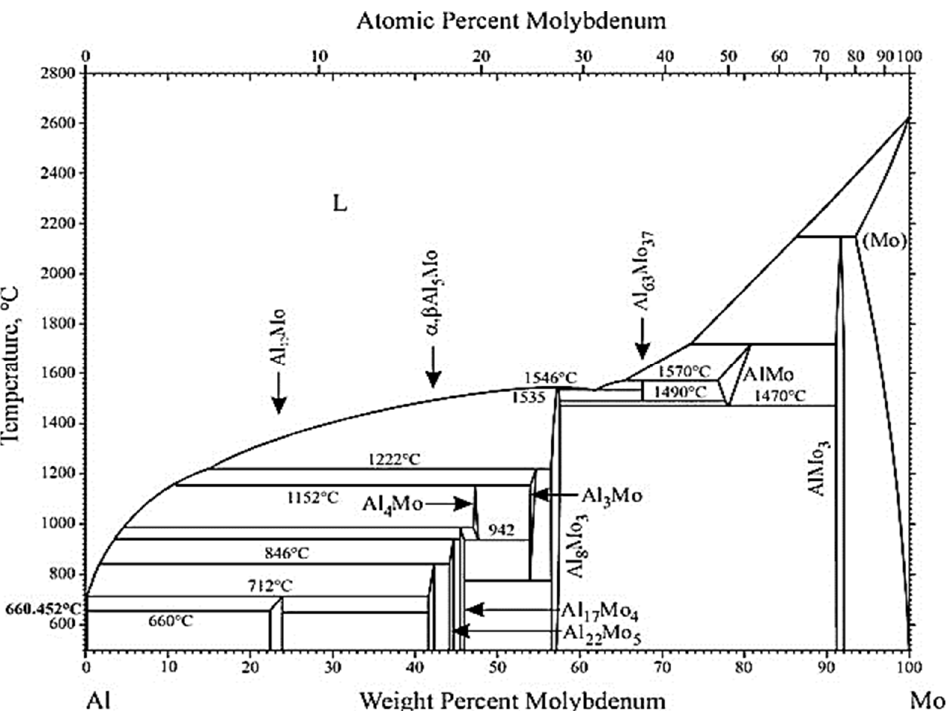
Figure 2. The Al ‐ Mo phase diagram by Okamoto [19]. Figure 2. The Al-Mo phase diagram by Okamoto